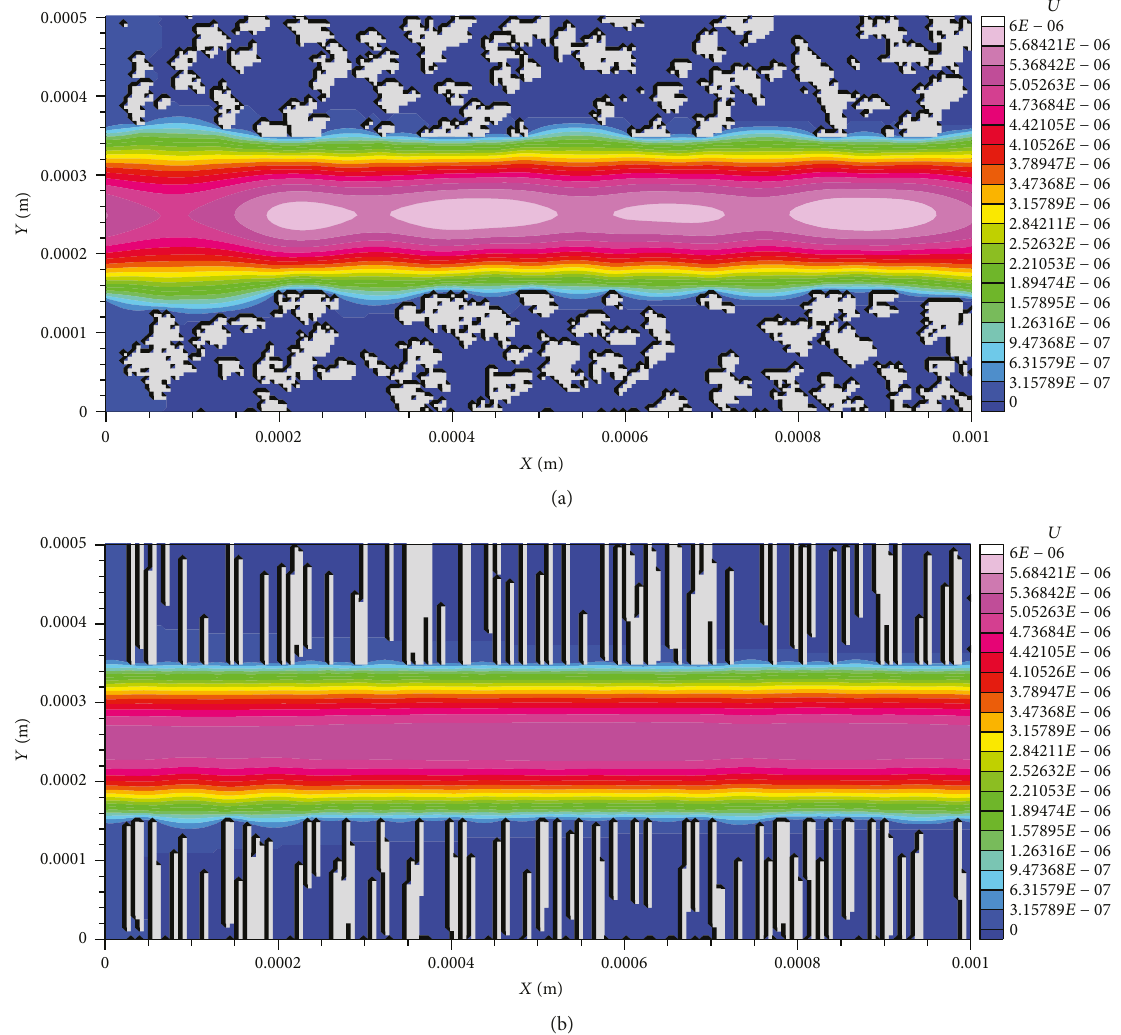
Figure 26: Velocity pro fi le (m/s) for cases with (a) mixed and (b) banded structures when Pe =2.6 for a multispecies case. In both (a) and (b), porosity (after dissolution) is near 0.47 but permeability (after dissolution) is 1.58 × 10 − 9 m 2 for (a) and 1.43 × 10 − 9 m 2 for